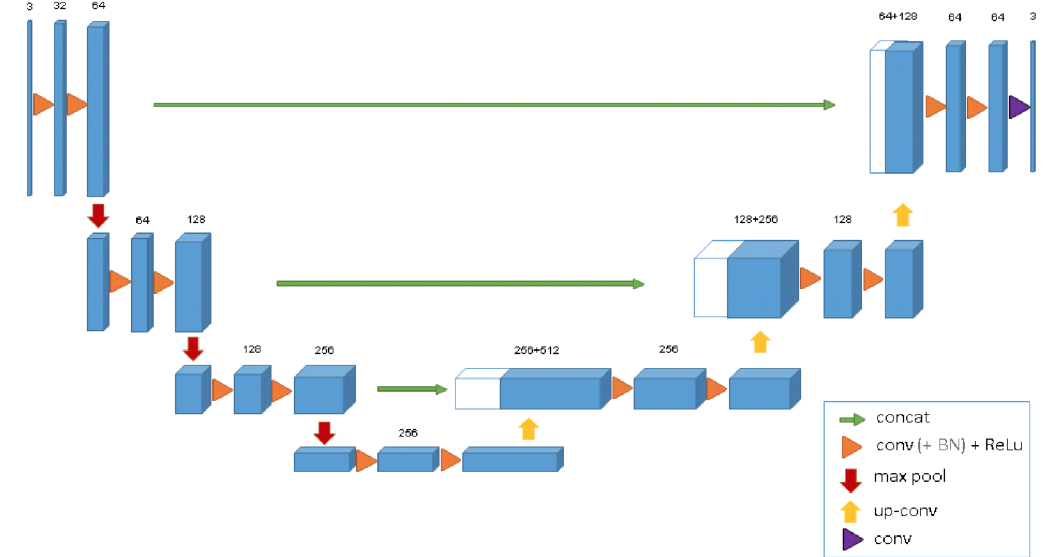
Figure 1. Diagram of the 3D U-Net [18]